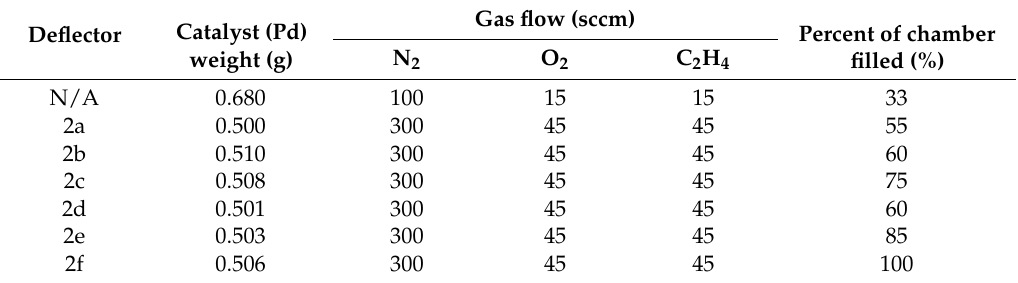
Table 1. Percent of chamber filled by foam by deflector design (numbers correspond to figure numbers in experimental section).